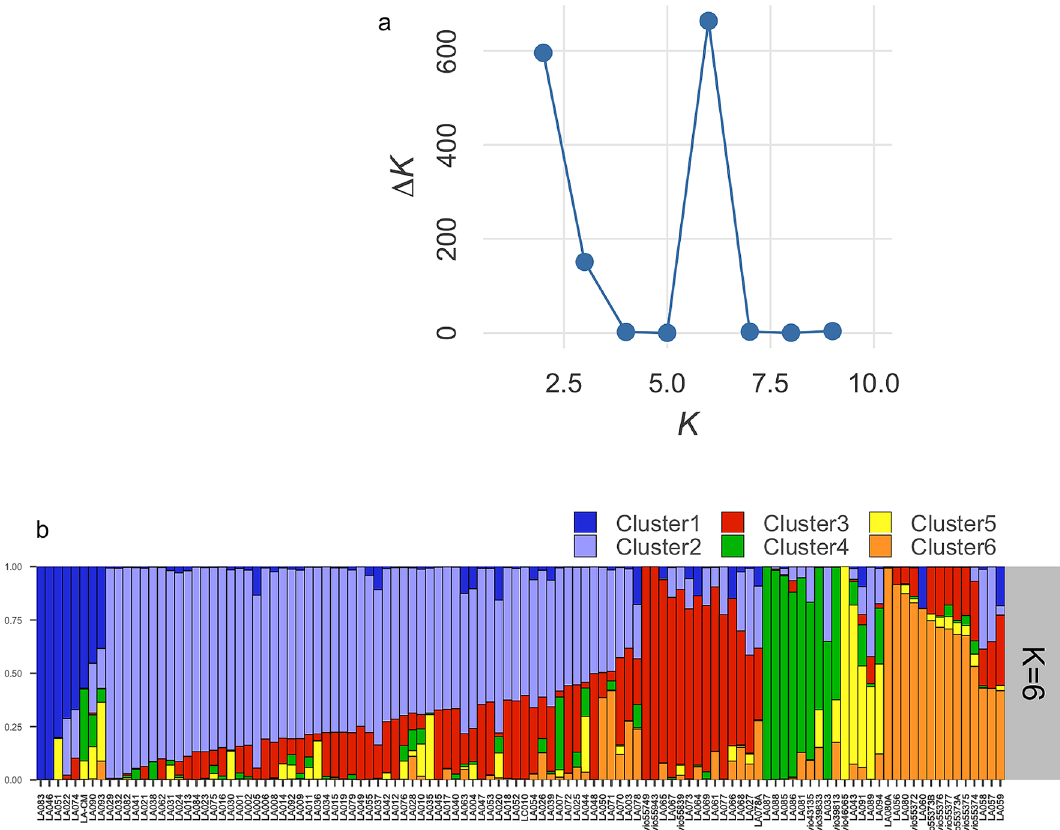
Figure 1. Population structure of 112 Luffa acutangula accessions using DArTseq-based SNP markers inferred by STRU CTU RE program. ( a ) Number of subpopulations indicated by the highest ΔK ; ( b ) Proportion of clustering of individuals to six